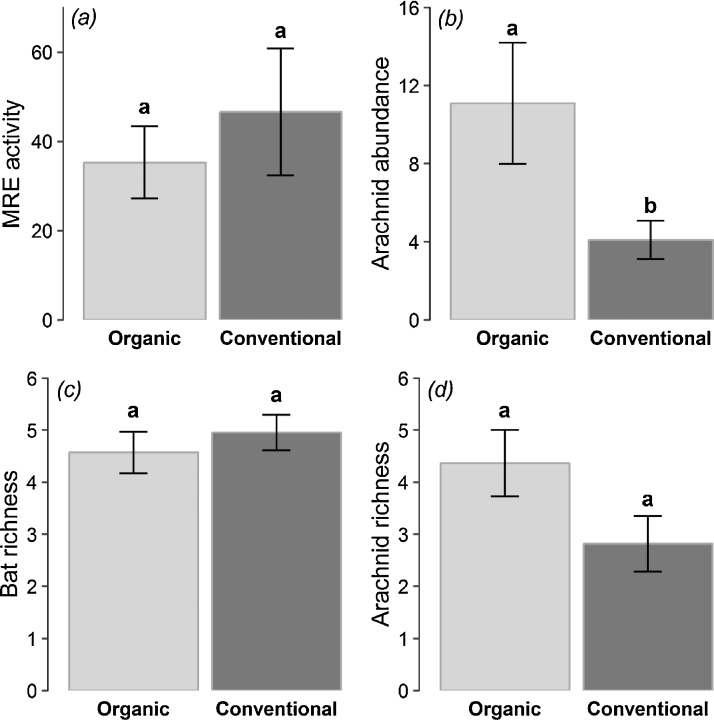
Mean (±SE) number of (a) bat passes of mid-range echolocator bats (MRE guild); (b) individuals of arachnids (spiders and harvestmen); (c) bat species; and (d) arachnid species in paired organic and conventional vineyards. Superscripts a and b are used to identify statistically significance differences between the two treatments (see Table 2).